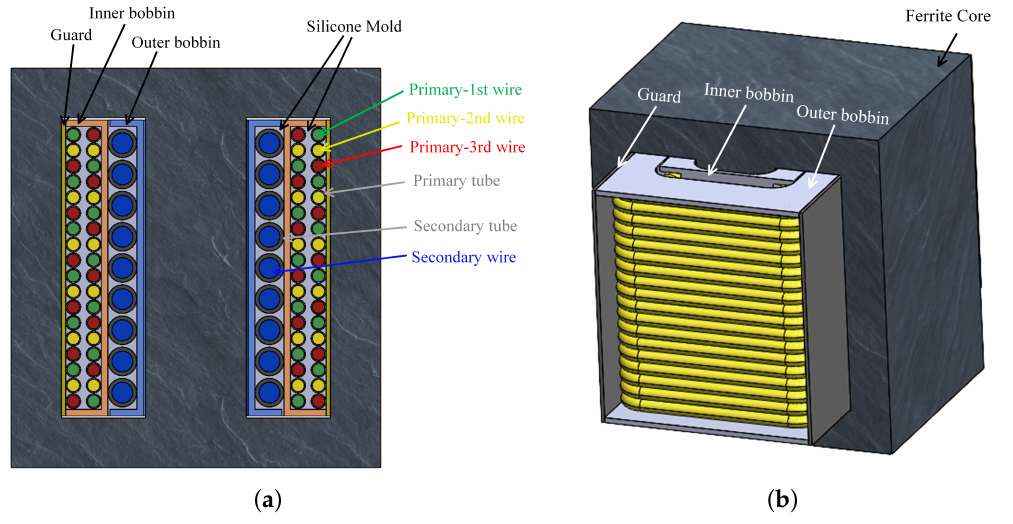
Figure 2. Transformer structure: ( a ) front cross-sectional view; ( b ) perspective